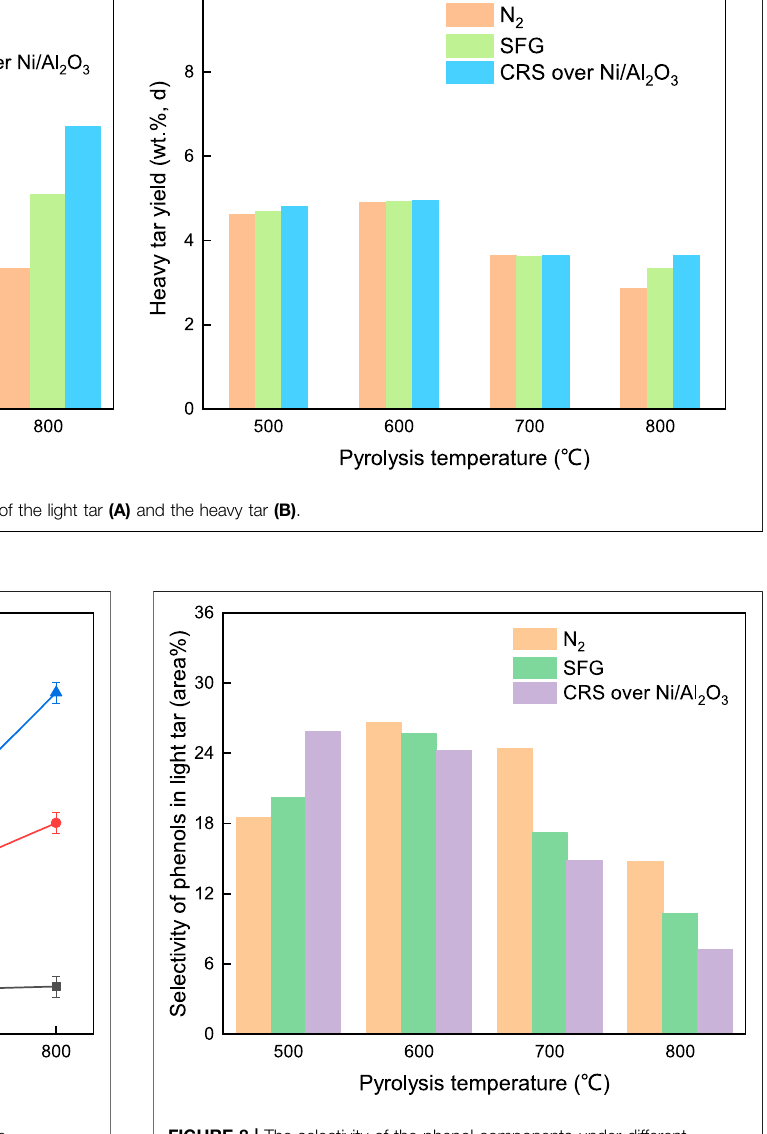
FIGURE 7 | Water evolution behavior under different atmosphere. FIGURE 8 | The selectivity of the phenol components under different